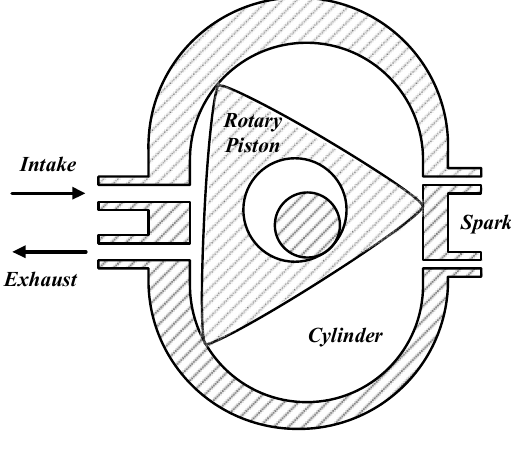
Figure 8. Rotary engine